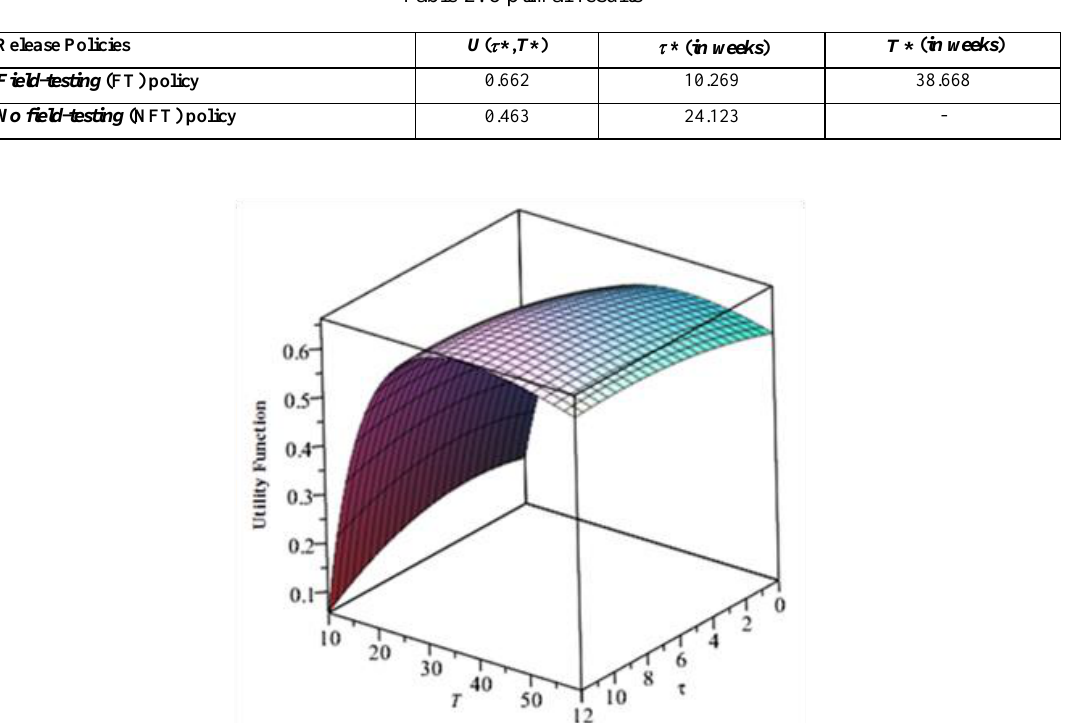
Table 2. Optimal results